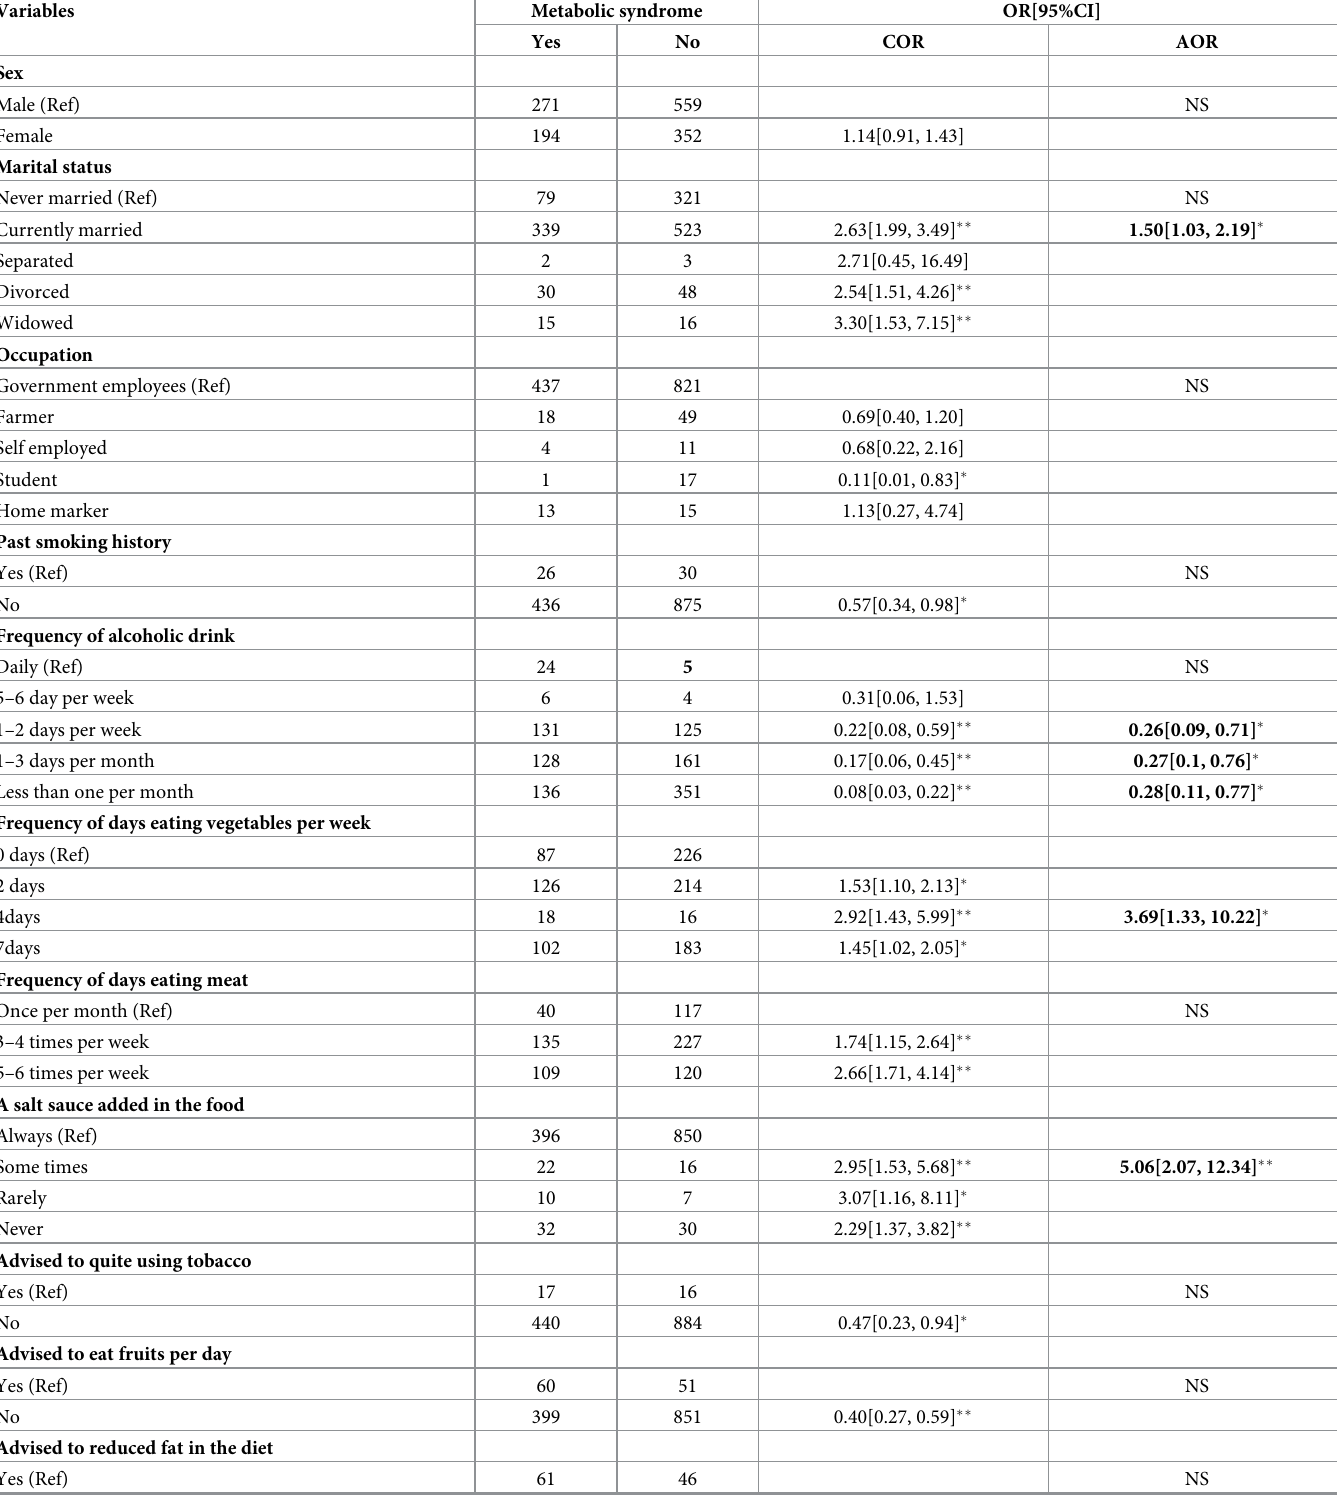
Table 3. Logistic regression analysis of factors associated with pre-diabetes and diabetes for study participants in Northern